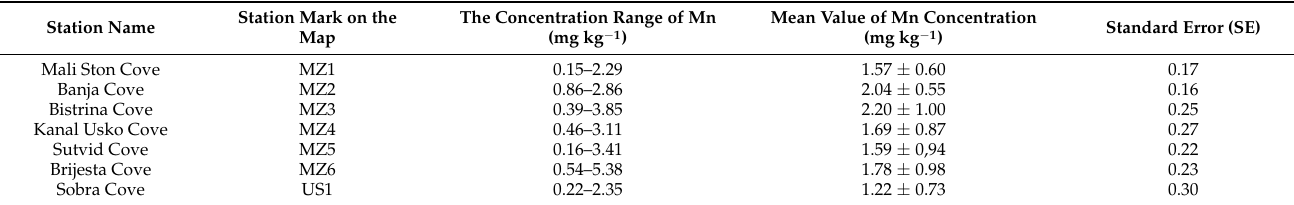
Figure 2. The mean values of Mn concentrations ± SE in blue mussels collected at seven stations from January to June 2011. NEG-DSP negative samples, while others are DSP positive samples. Concentrations of Mn are expressed per wet weight (w wt). The mean values of Mn concentrations with standard errors (SE) in DSP positive samples for all stations, and the mean Mn concentration with SE in DSP negative samples are shown on the graph. Table 2. The ranges, mean values, and standard errors of Mn concentrations measured on each control station in the DSP positive